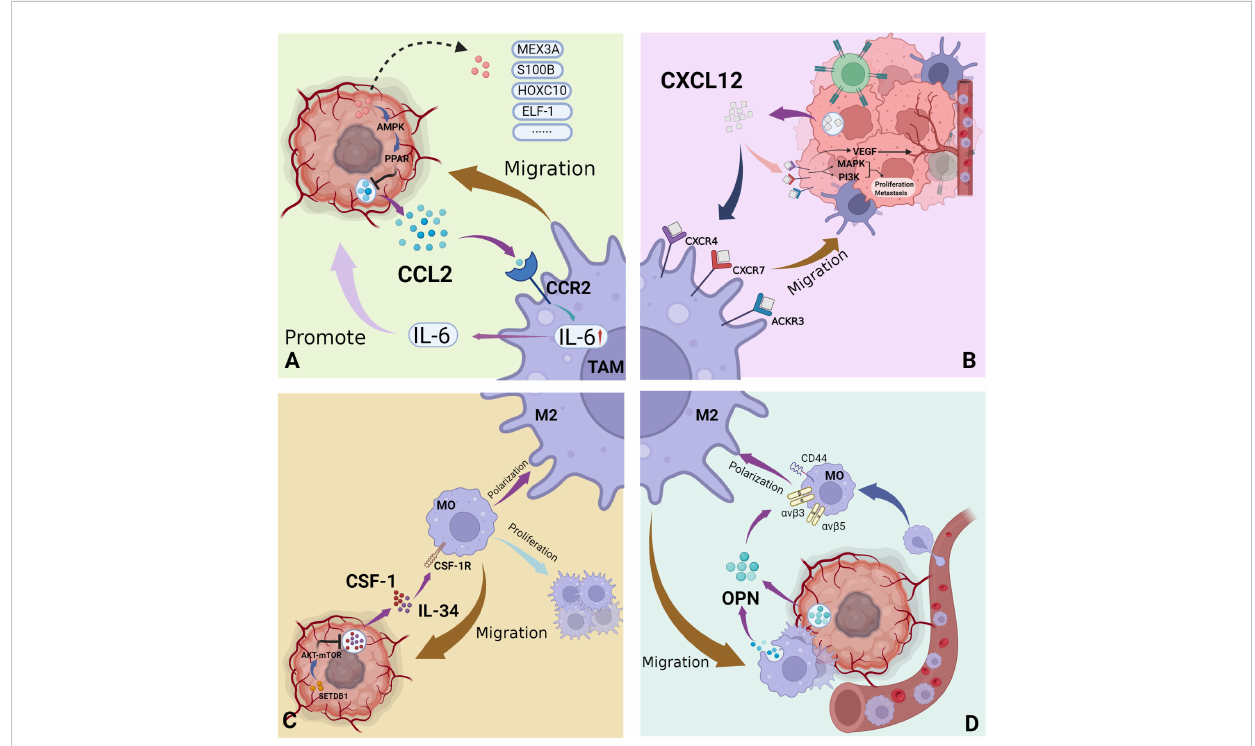
FIGURE 3 Major recruitment factors of GAMs in the glioma immune microenvironment. (A) CCL2 secreted by glioma cells acts on its receptor CCR2 on macrophages, effectively mediating the migration of macrophages to tumor sites and the secretion of tumor-promoting cytokines; (B) The three main receptors of CXCL12 secreted by gliomas: CXCR4, CXCR7, ACKR3, exist on the surface of both tumor cells and macrophages. Mediates the recruitment of macrophages, as well as tumor cell proliferation, metastasis and angiogenesis. (C) As ubiquitous cytokines, CSF-1 and IL-34 act on the receptor CSF-1R to mediate the recruitment of macrophages and the proliferation and differentiation of macrophages. (D) OPN is secreted by tumor cells and macrophages and induces the recruitment and polarization of macrophages. (By